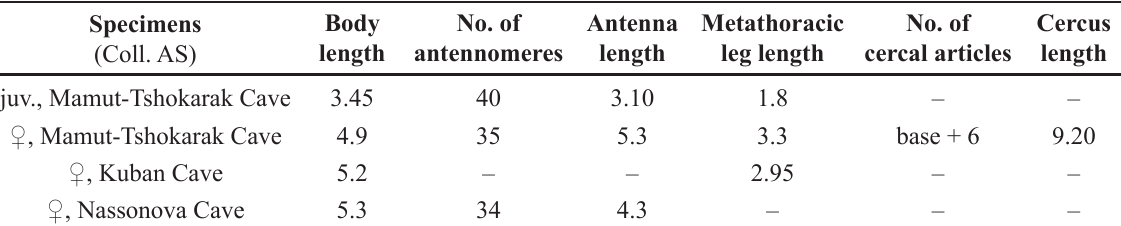
Table 1. Plusiocampa ( Dydimocampa ) evallonychia Silvestri, 1949. Length of the body, antennae, metathoracic legns and cerci (measurements in mm), in addition to the number of antennomeres and cercal